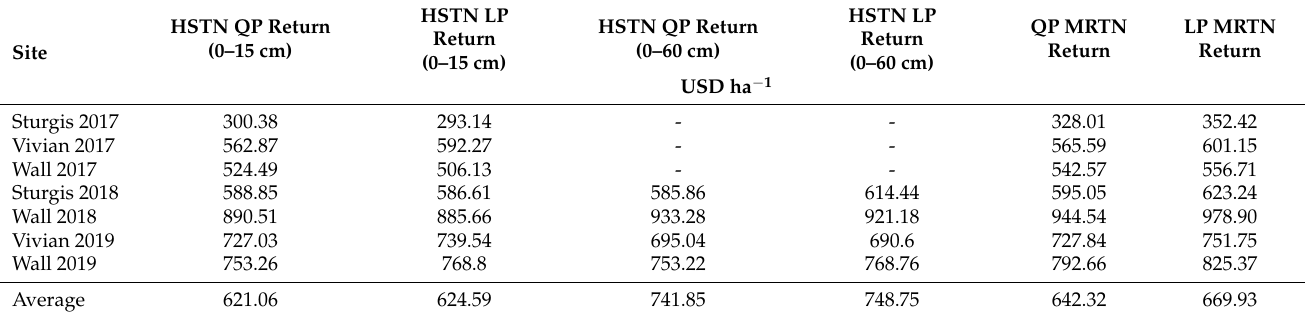
Table 5. Estimated returns (USD ha − 1 ) for the linear plateau (LP) and quadratic plateau (QP) model parameters at the estimated Haney soil test (HST) and MRTN